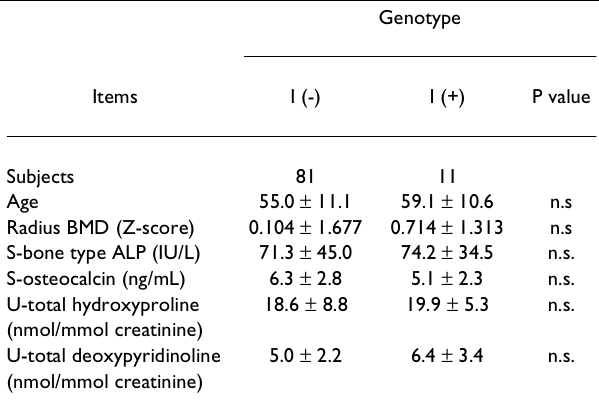
Table 2: Comparison of background and biochemical data of GD patients in remission between the two groups of genotype